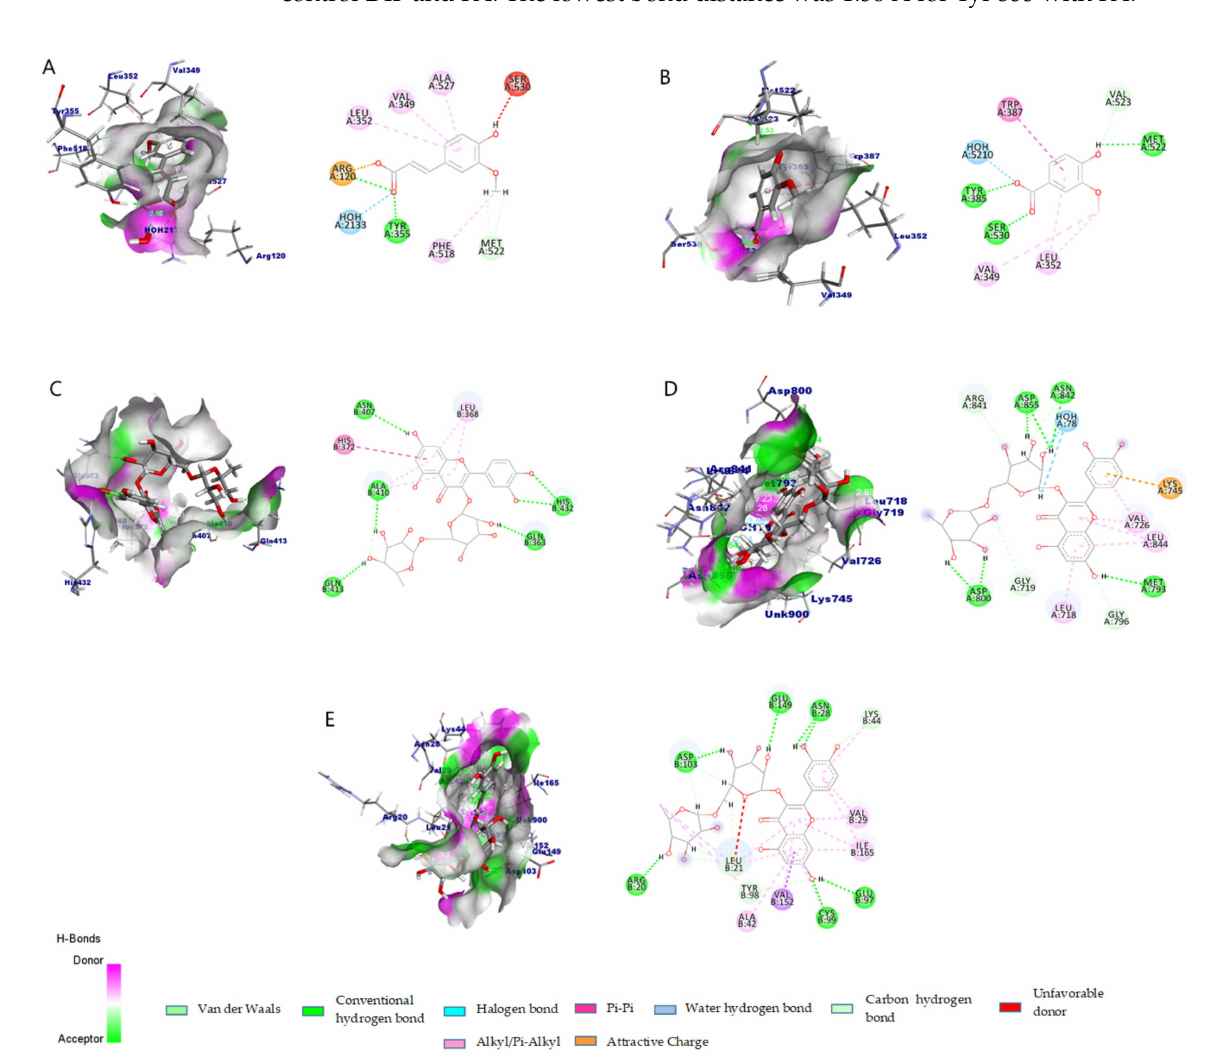
Figure 5. Graphical representation of non-bond interactions for top compounds with each target’s active site. ( A – E ) Repre- sent the interactions for COX-1, COX-2, LOX-5, EGFR, and IKK